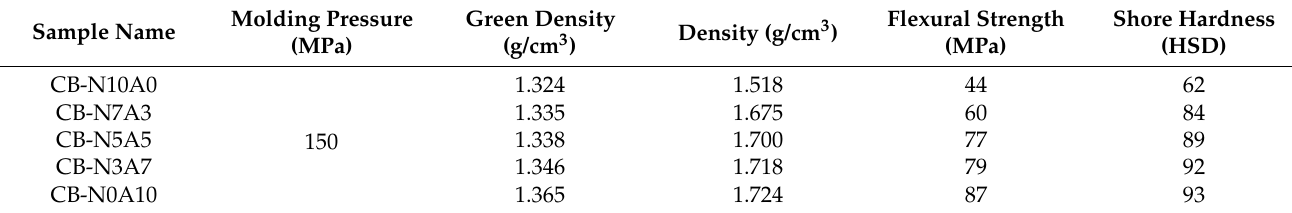
Table 5. Mechanical properties of high-density carbon according to the flow rate of